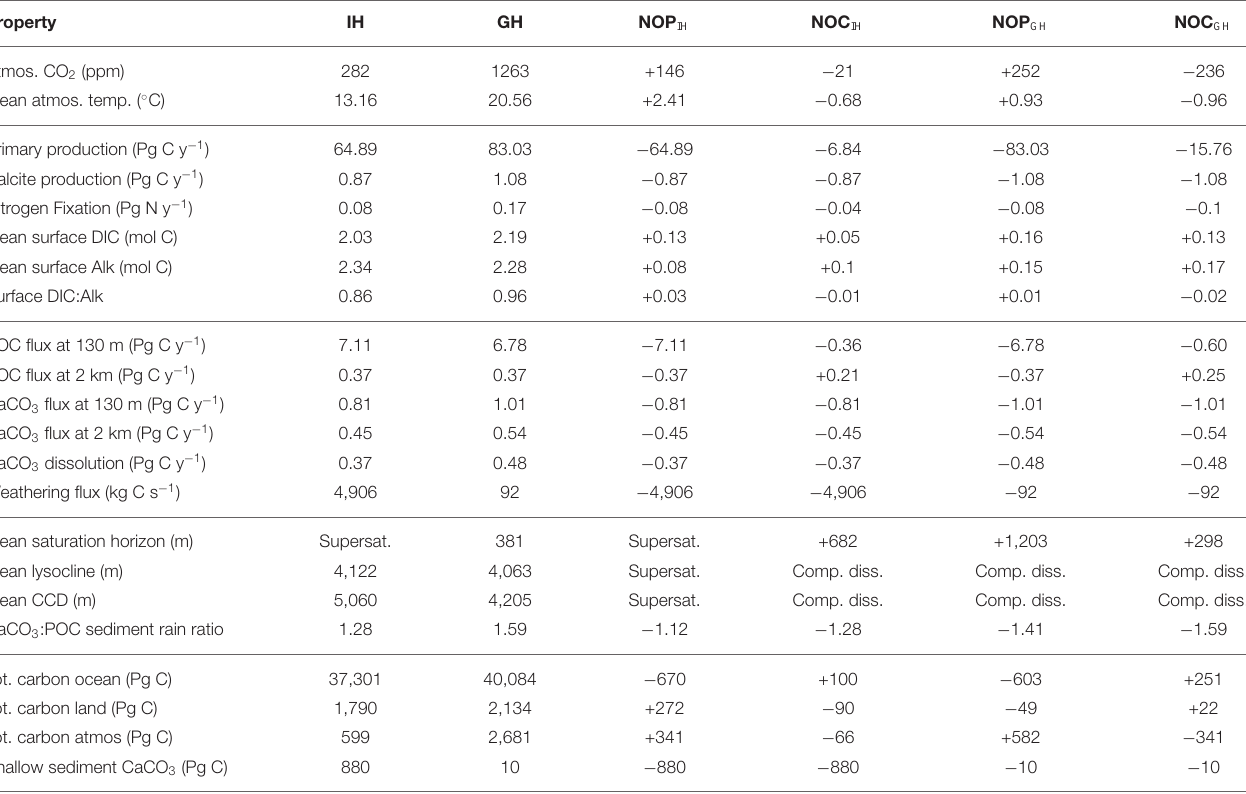
TABLE 1 | Diagnosed global biogeochemical properties in icehouse (IH) and greenhouse (GH) climates, and change in these properties under Strangelove forcing. Property